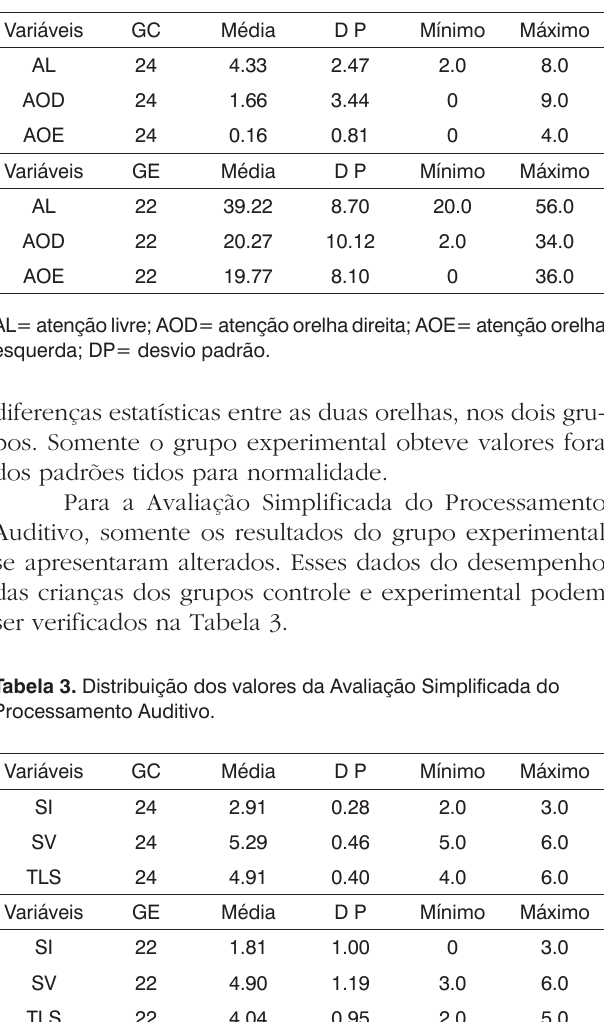
Tabela 2. Resultados do teste Dicótico de Dígitos em número de